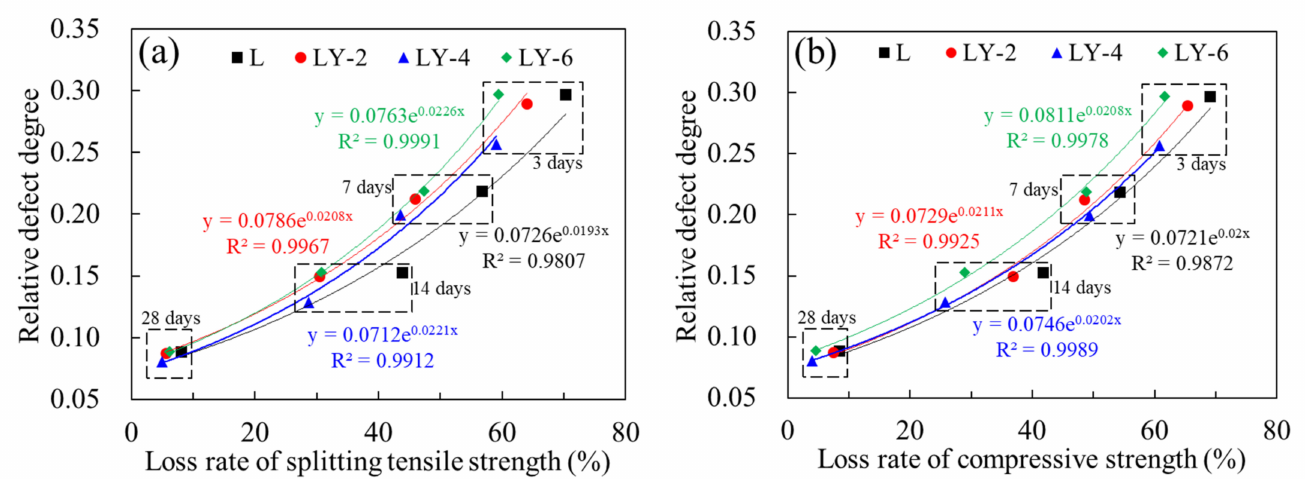
Figure 7. Relationship between relative damage degree and loss rate of strength: ( a ) splitting tensile strength and ( b ) com- pressive